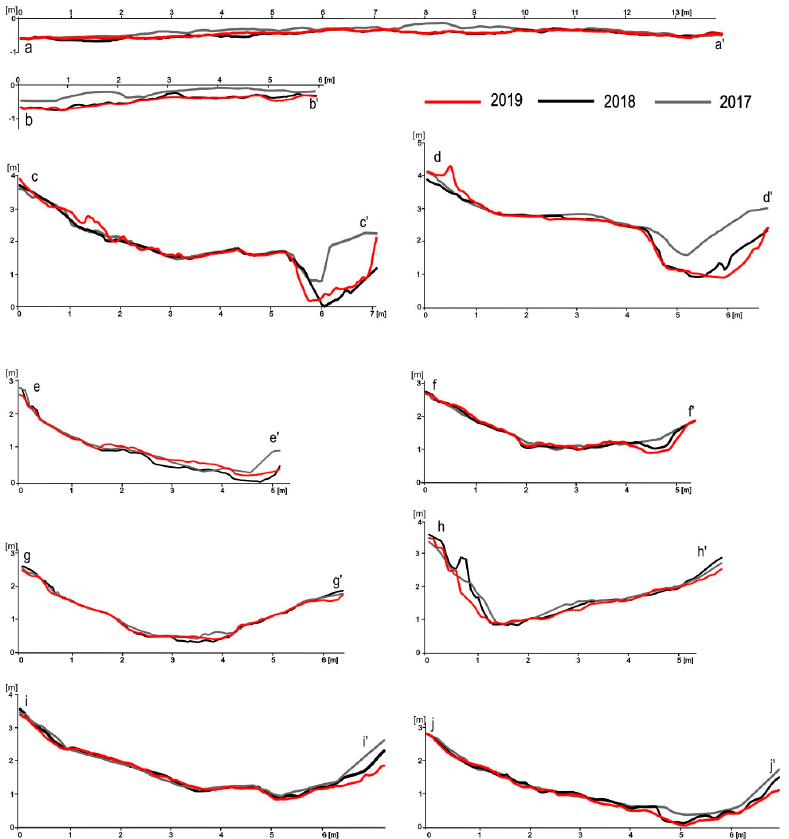
Figure 5. Changes at selected cross profiles along the studied forest road and within accumulation fan in the years 2017–2019. Changes in the accumulation fan at the end of the road ( a , b ). Changes in the erosion gully in the lower part of the road ( c , d ). Changes within the road surface without clearly developed erosion cuts ( e–j ). Locations of the profiles are marked on Figure 3. Changes at subsequent measurement sites along the studied road were significantly smaller in the periods under analysis. The maximum deepening in the period 2017–2018 was in the range from 0.32 (profile ff’) to 0.71 m (profile ee’). However, in the period 2018–2019 the maximum deepening ranged from 0.2 (profile ee’) to 0.5 (profile ii’). The largest transformation in all the analyzed profiles occurred on the surface of the road, and the smallest occurred at road undercuts (profiles dd’, ff’, gg’, jj’).